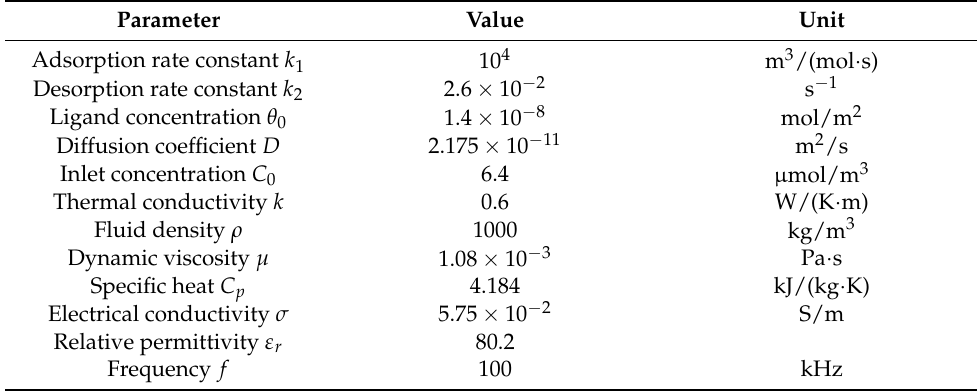
Table 4. Numerical values of the parameters used in the current simulations [12,23,25].